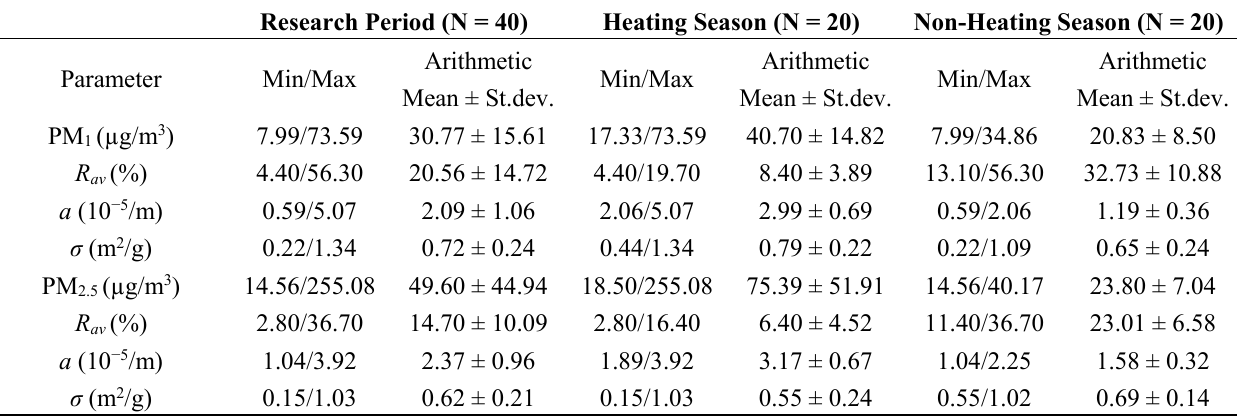
Table 2. Statistics for the optical parameters of PM 1 and PM 2.5 at UB (urban background